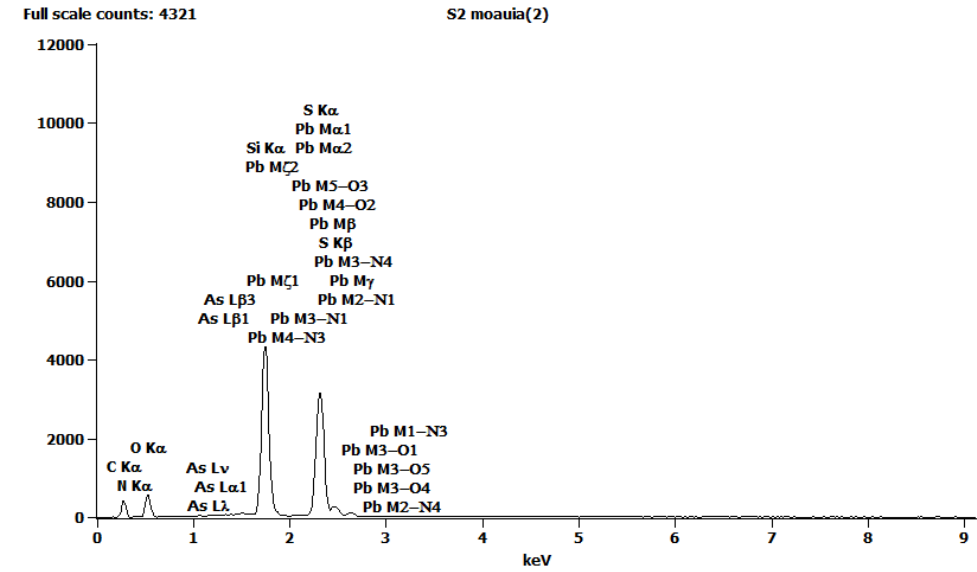
Figure 8. (EDX) spectrum of adsorbent 1 after adsorption. Table 2. (EDX) data of adsorbent 1 after adsorption.